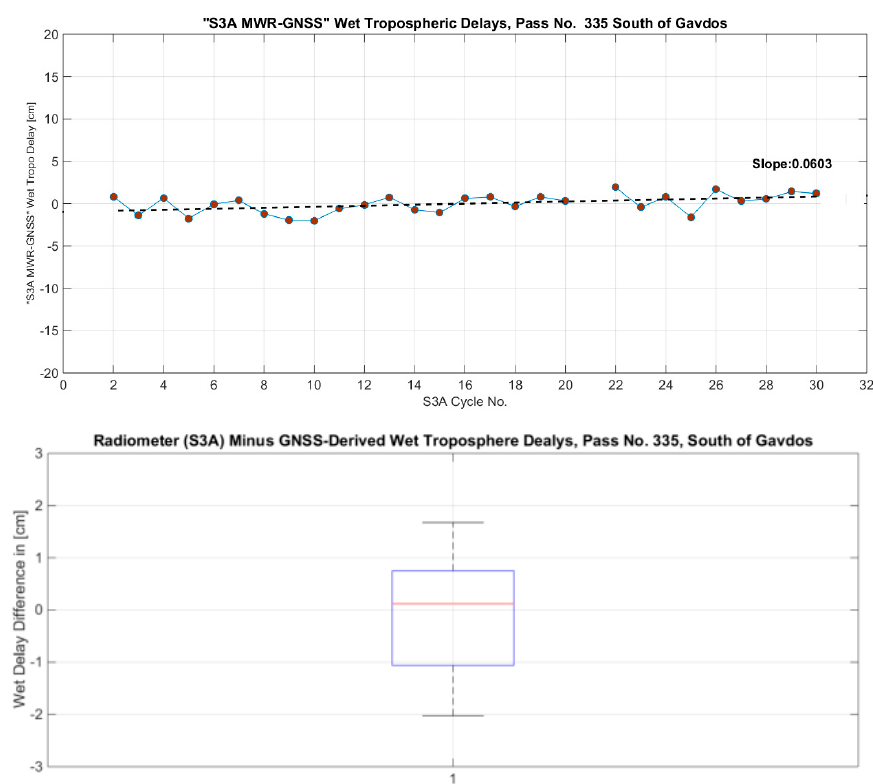
Figure 17. Differences between the S3A Radiometer and the GNSS-Derived delays for the Wet Troposphere as a function of cycle number. It seems that there is an upward trend with a slope of +0.0603 cm/cycle (S3A descending Pass No.335). The standard error for this estimated slope is SE = ± 0.0245 cm/cycle and its p -value is 0.0137 which determines the significance of these results (98%). The plot, below the first diagram above, is the boxplot of these delay differences. It can be seen that the location estimate (horizontal red line in the middle) is the median (slightly above zero). The average value, however, comes to − 0.09 cm, a value also close to zero. The standard deviation for this average is ±2 mm.